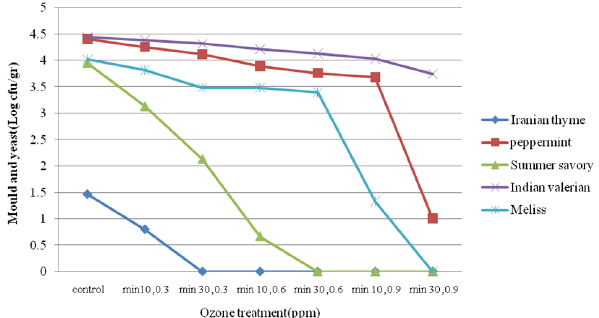
Fig. 4. The effect of treatment of Ozone gas on the mold and yeast in medicinal